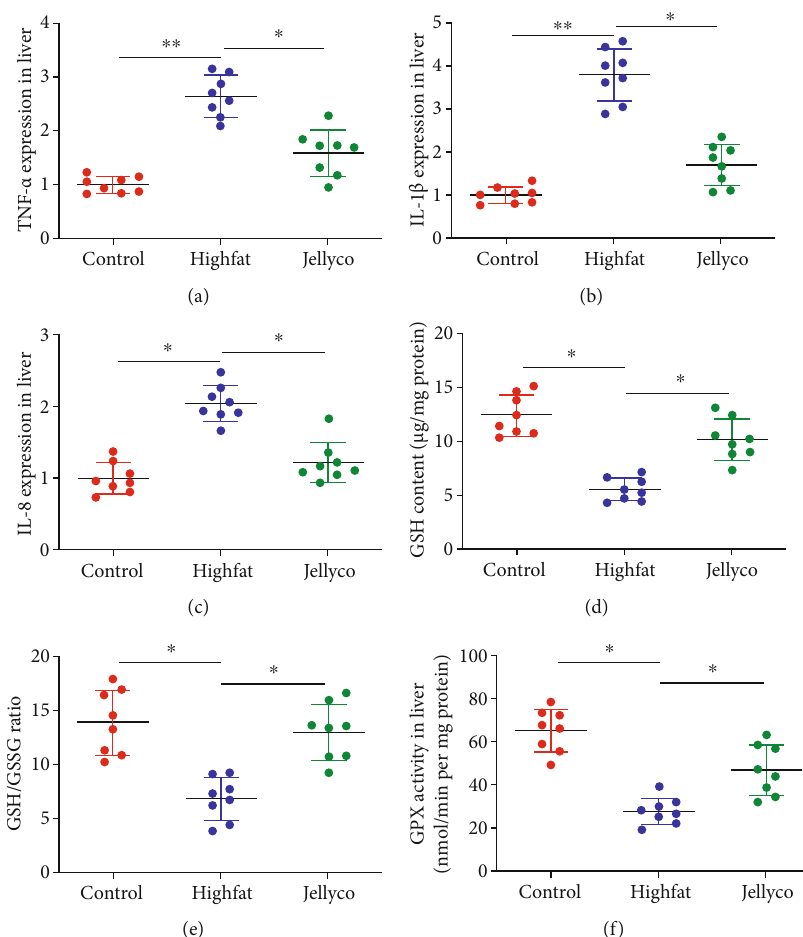
Figure 2: Jelly fi sh collagen hydrolysate alleviated in fl ammation and oxidative stress in liver of high-fat diet-fed mice. Gene expression of TNF- α (a), IL-1 β (b), and IL-8 (c), (d) GSH content, (e) GSH/GSSG ratio, and (f) GPX activity. Data are expressed as means ± SEM , n = 8 . ∗ P < 0 : 05 , ∗∗ P < 0 : 01 .